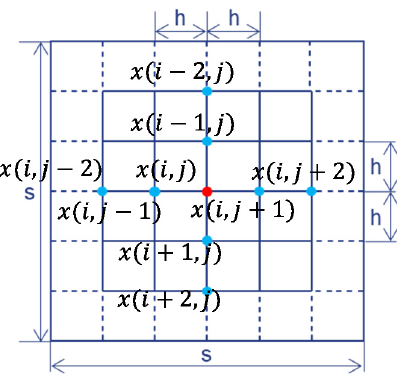
Figure 4. The spatial division method of finite di ff erence (FD) method is nine-point di ff erence of central format.